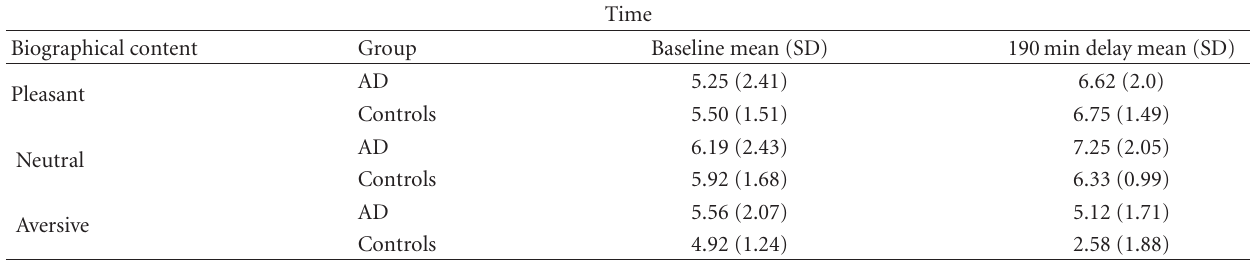
Table 1: Mean valence ratings of AD patients and controls for pictures paired with pleasant, aversive, and neutral content at two measurement time points.